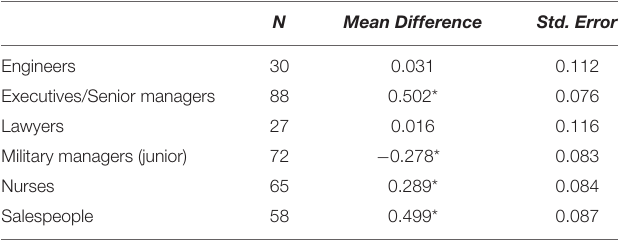
TABLE 4 | Correlations between Trait EI (Global and Factor Scores), job satisfaction, and job performance in